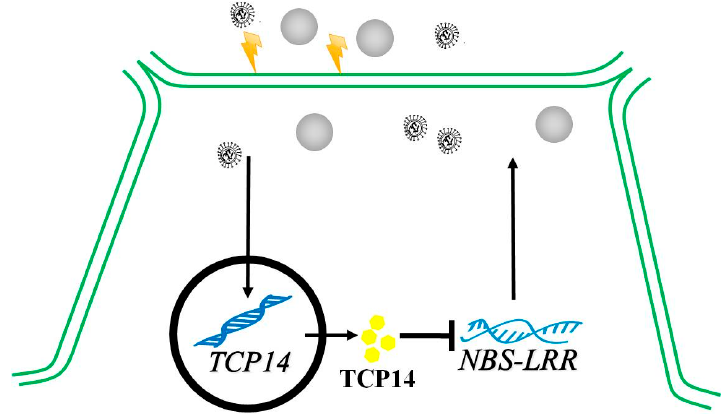
Figure 6. The deducted model of CsTCP14 regulatory the susceptibility to foliage diseases. The CsTCP14 was upregulated under foliage disease attack, then repressing the expression of defense gene CsNBS-LRR transcriptionally, induced the susceptibility to foliage